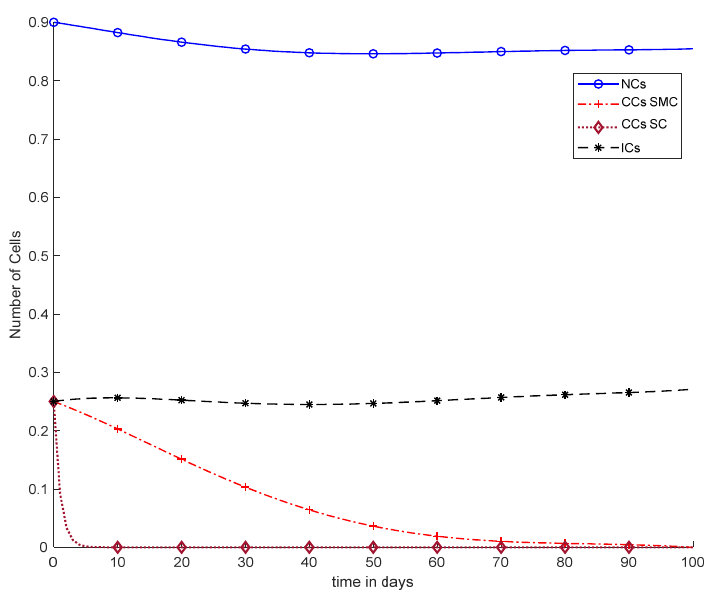
19 of 25 Figure 12. With chemotherapy at a continuous dose and SMC on CCs (‘+’ line) with effect on all equations and SC on CCs (‘ − ’ line). In Figure 11, case-6a shows the comparison of SMC and SC, in which we utilized constant-dose chemotherapy, and ICs and NCs are at normal level. However, CCs were eliminated in five days with the help of SC. However, using SMC, CCs were minimized in about eighty days. Moreover, in Figure 12, case-6b illustrates an exponential continu- ous dose with chemotherapy, where using SMC, CCs are reduced nearly in sixty days. However, NCs and ICs are disturbed, which affects the body. In contract with SMC, SC completely removed CCs within five consecutive days. In Figure 13, case-6c shows the idea that SC especially is designed for CCs; later, we utilize the same concept in all other